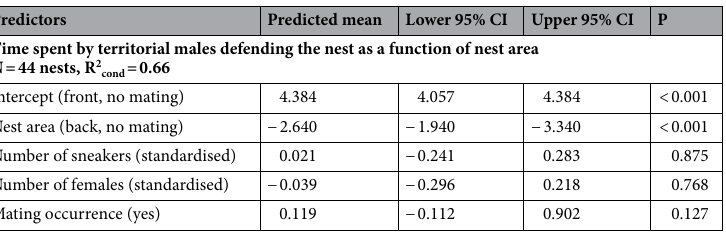
Table 2. Statistical analysis: defensive behaviour of territorial males. Generalized Linear Mixed Model with time spent by territorial males defending the nest as response variable. Predicted means and their credible intervals (CI) are based on a negative binomial distribution with log-link (see Materials and methods). For factorial predictors, estimates are computed using the indicated intercept level as reference. This choice is arbitrary and does not affect overall conclusions.